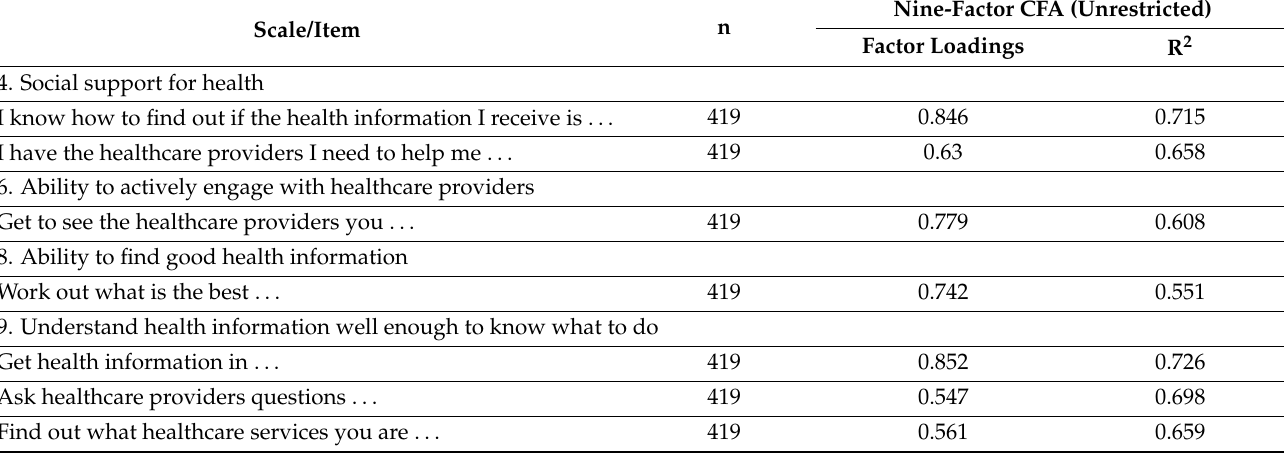
Table 3. Cross-loadings of items in different factors obtained through unrestricted nine-factor